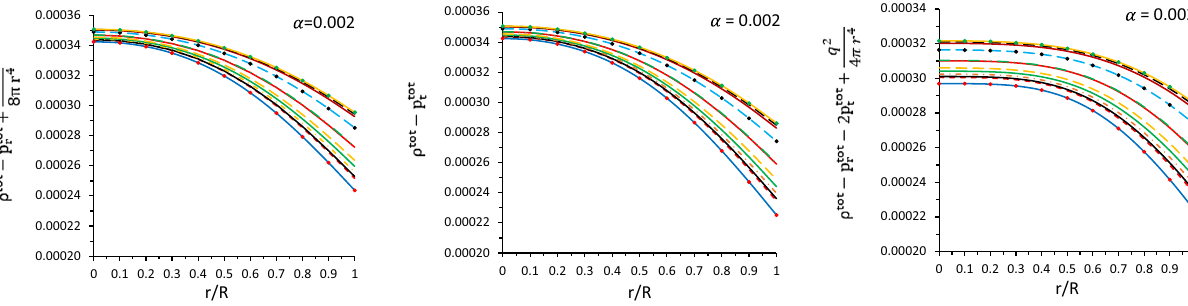
Fig. 7 The behavior of dominant energy conditions and trace energy condition versus radial coordinate r / R by taking the numerical values of the constants a = 0 . 003, b = 0 . 0000053, β = 1 . 1, and γ = − 0 .